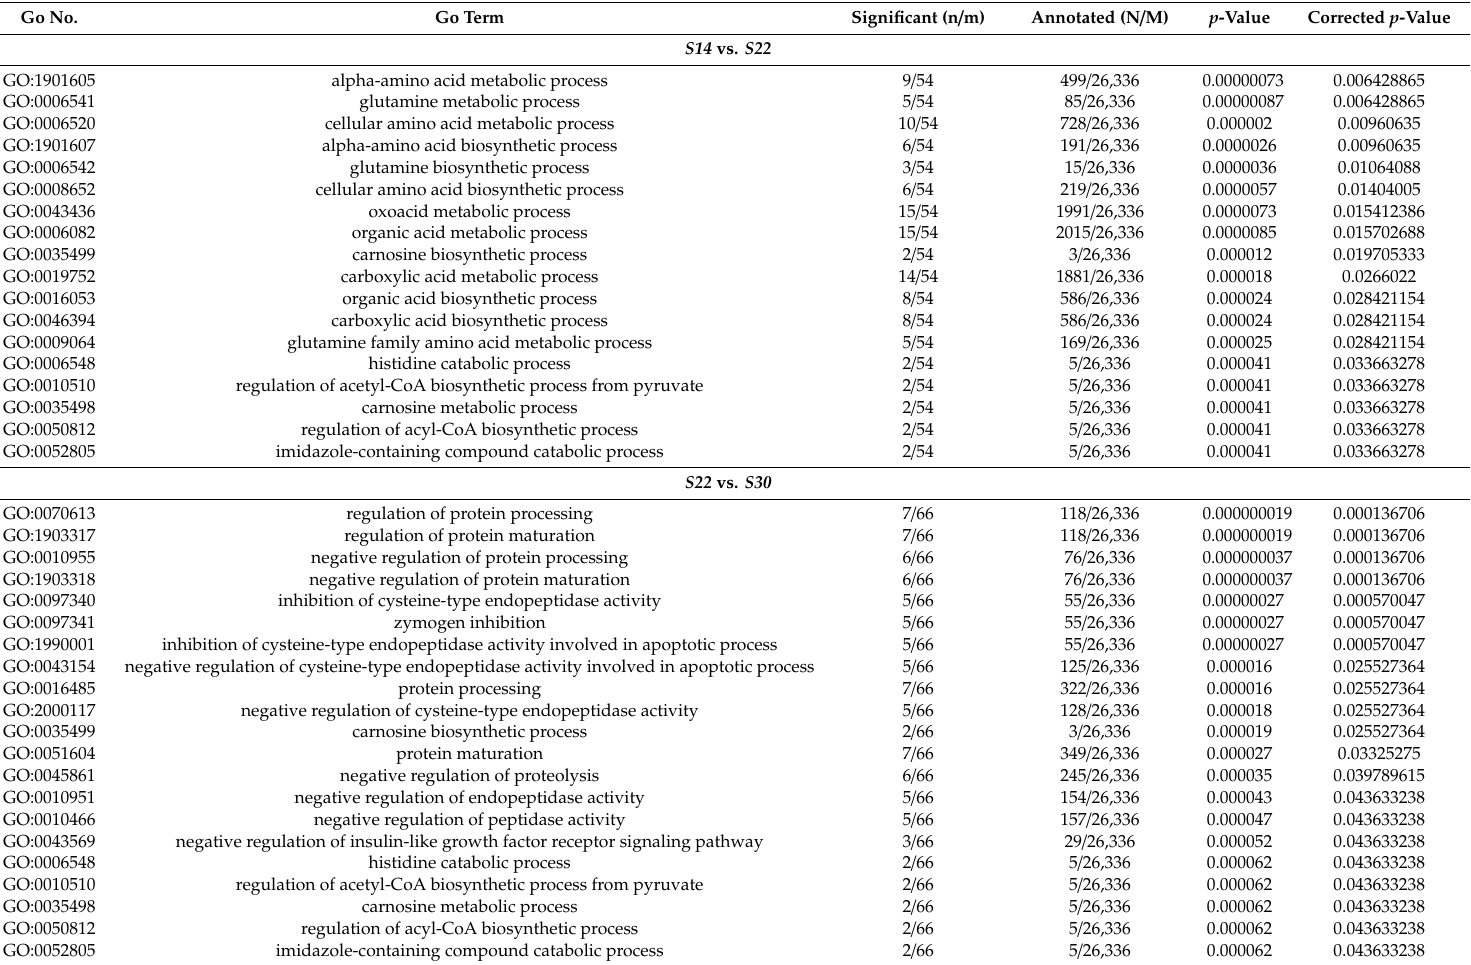
Table 5. Significantly enriched GO terms in DEGs at di ff erent salinity